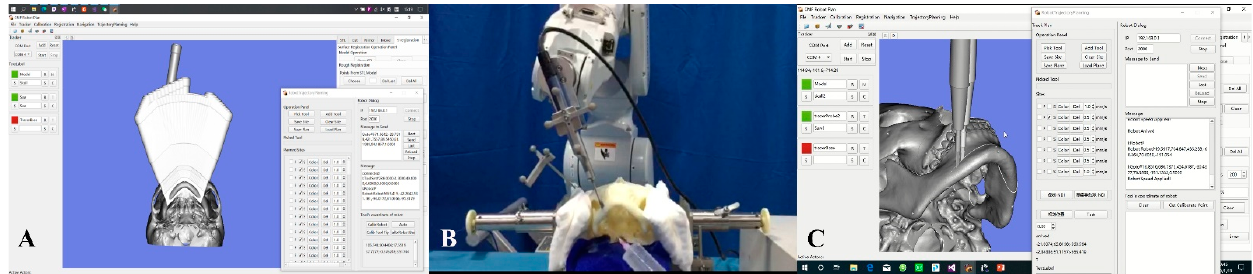
Figure 2. Robot-assisted chin osteotomy. ( A ) The robot’s surgical trajectory was planned based on the osteotomy plane determined by VSP. The virtual reciprocating saws were set parallelly along the osteotomy plane. ( B ) The robot was automatically performing the chin osteotomy. ( C ) Synchronous screenshot of the software showed the robot-assisted chin osteotomy.